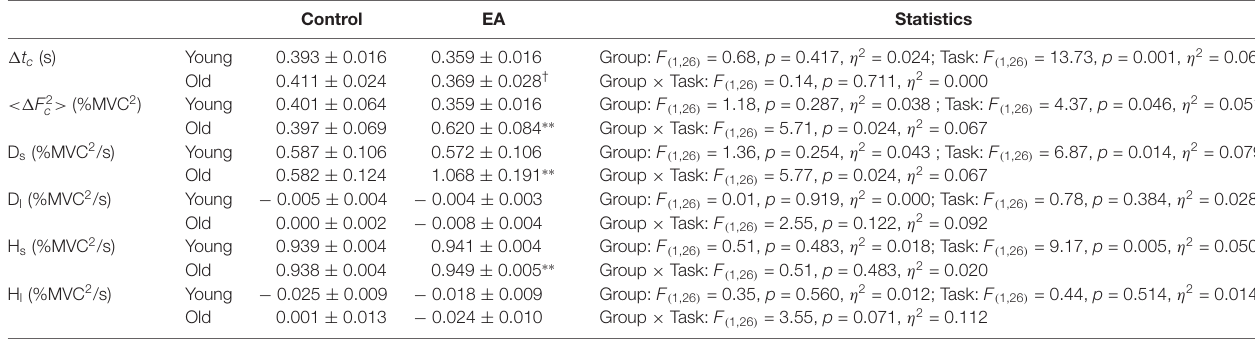
TABLE 2 | Parameters of stabilogram diffusion analysis of static force tracking for young and old groups in the control and EA conditions. Control EA